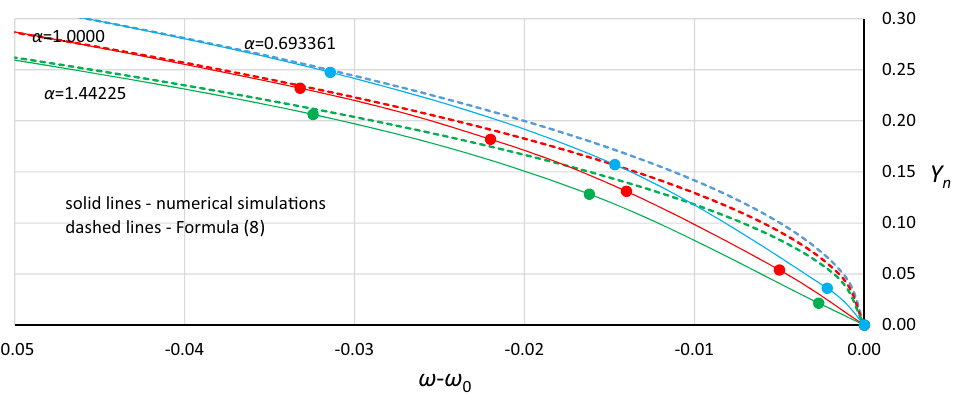
Figure 13. Flattening of relative curves of the origin point P B obtained on the basis of numerical simulations and the deterioration of coincidence with formula (9) for Y n ≤ 0.20 (the area of small damping